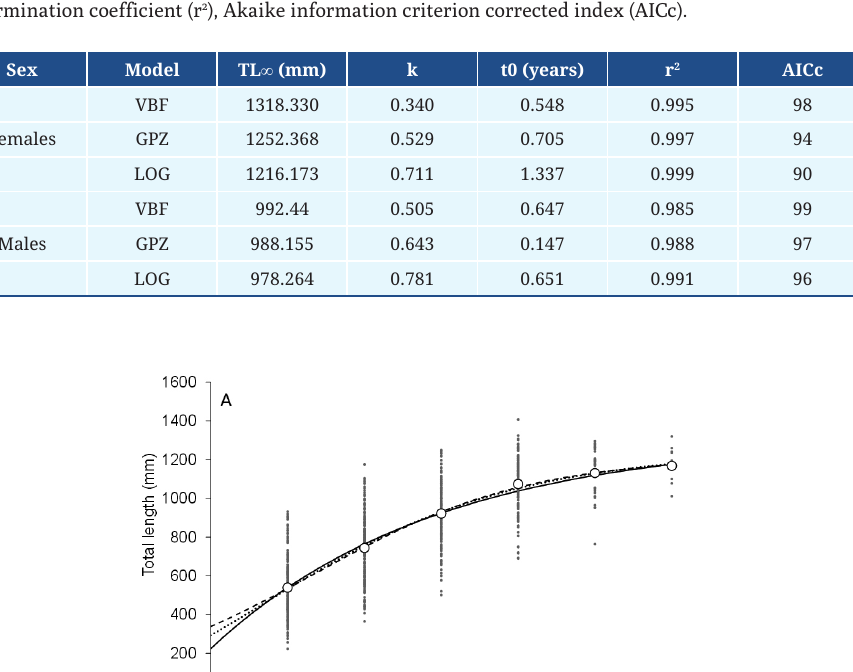
TABLE 3 | Parameters growth models Von Bertalanffy (VBF), Gompertz (GPZ) and logistic (LOG), fitted to the mean total length (TL) at age for females and males of Pseudoplatystoma corruscans. Asymptotic total length mm (TL∞), growth constant (k), = hypothetical time at zero length in years (t0), determination coefficient (r 2 ), Akaike information criterion corrected index